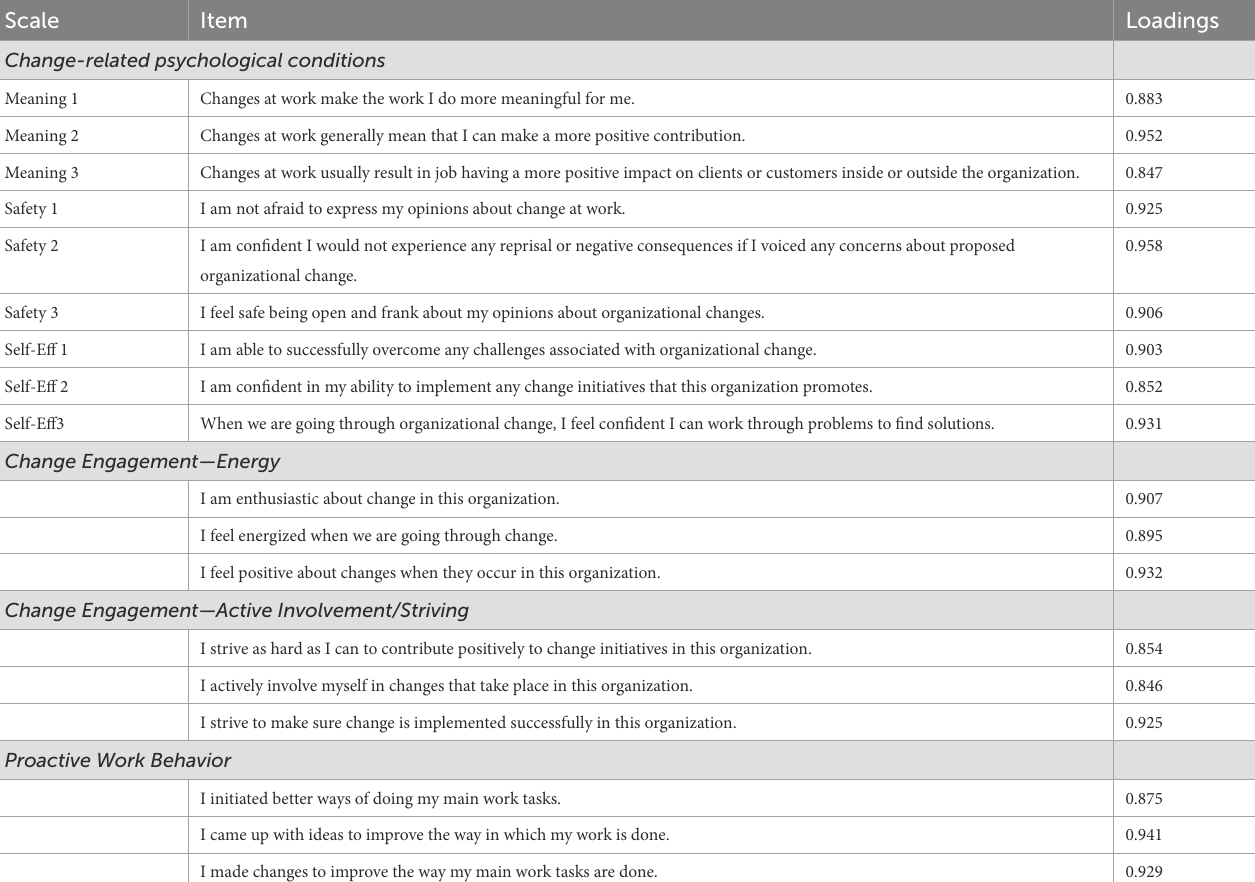
TABLE 2 CFA items and standardized